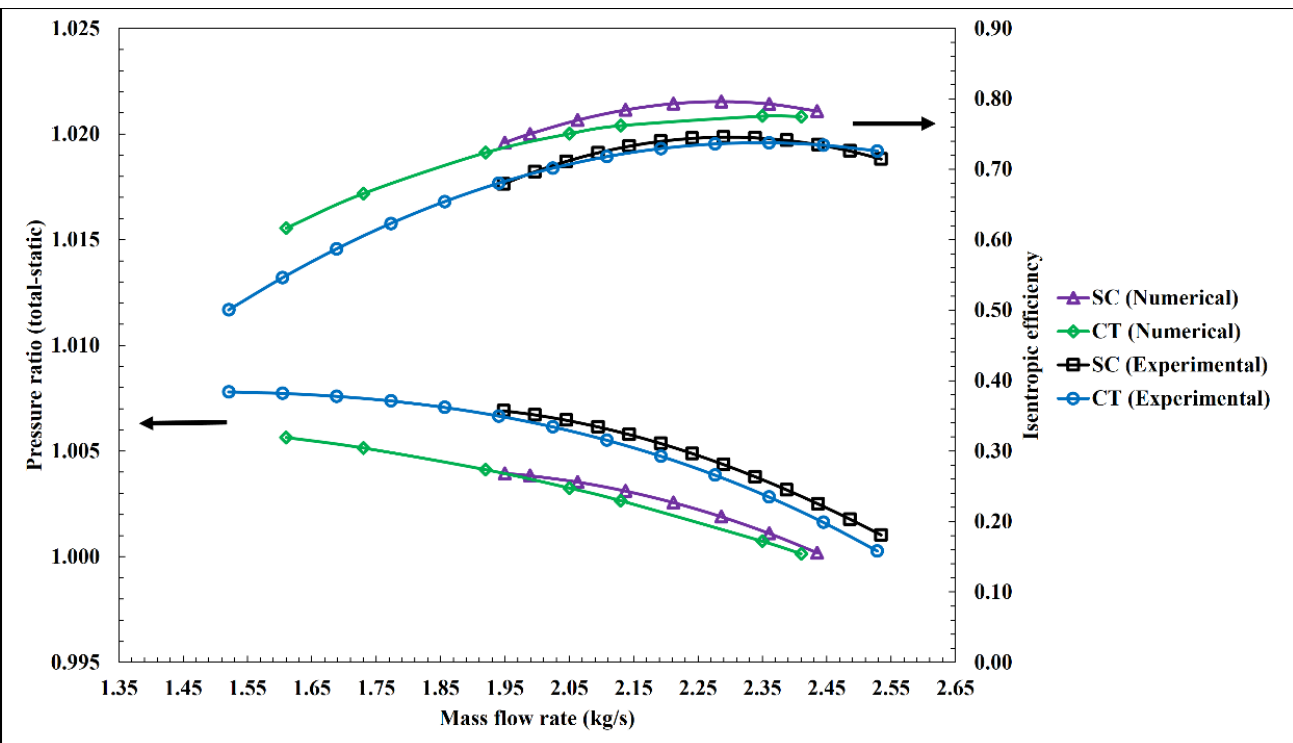
Figure 9. Pressure ratio and isentropic efficiency versus mass flow rate.